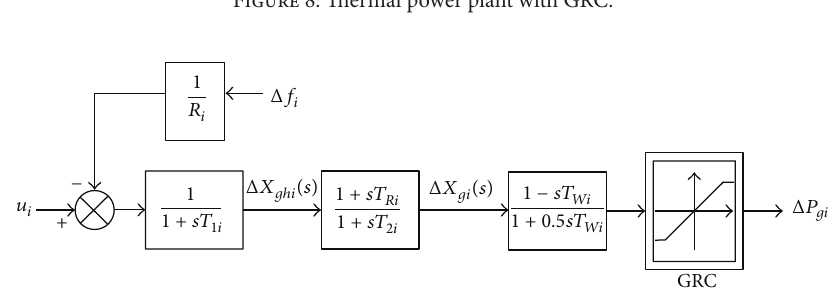
Figure 9: Hydro power plant with